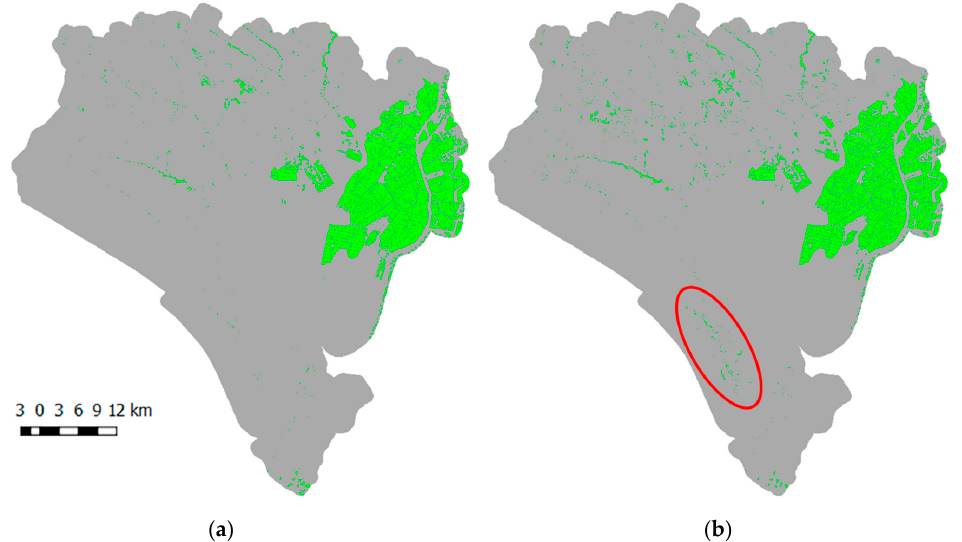
9. Figure 9. Water-vegetation subclass map relying on ( a ) MNDVI and ( b ) NDVI, where the water-vegetation areas are denoted with